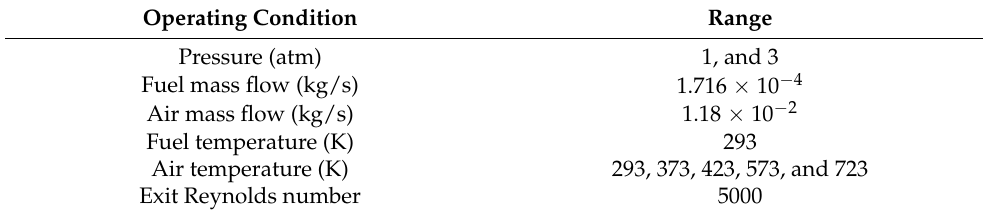
Table 5. Details of operating conditions used in the present